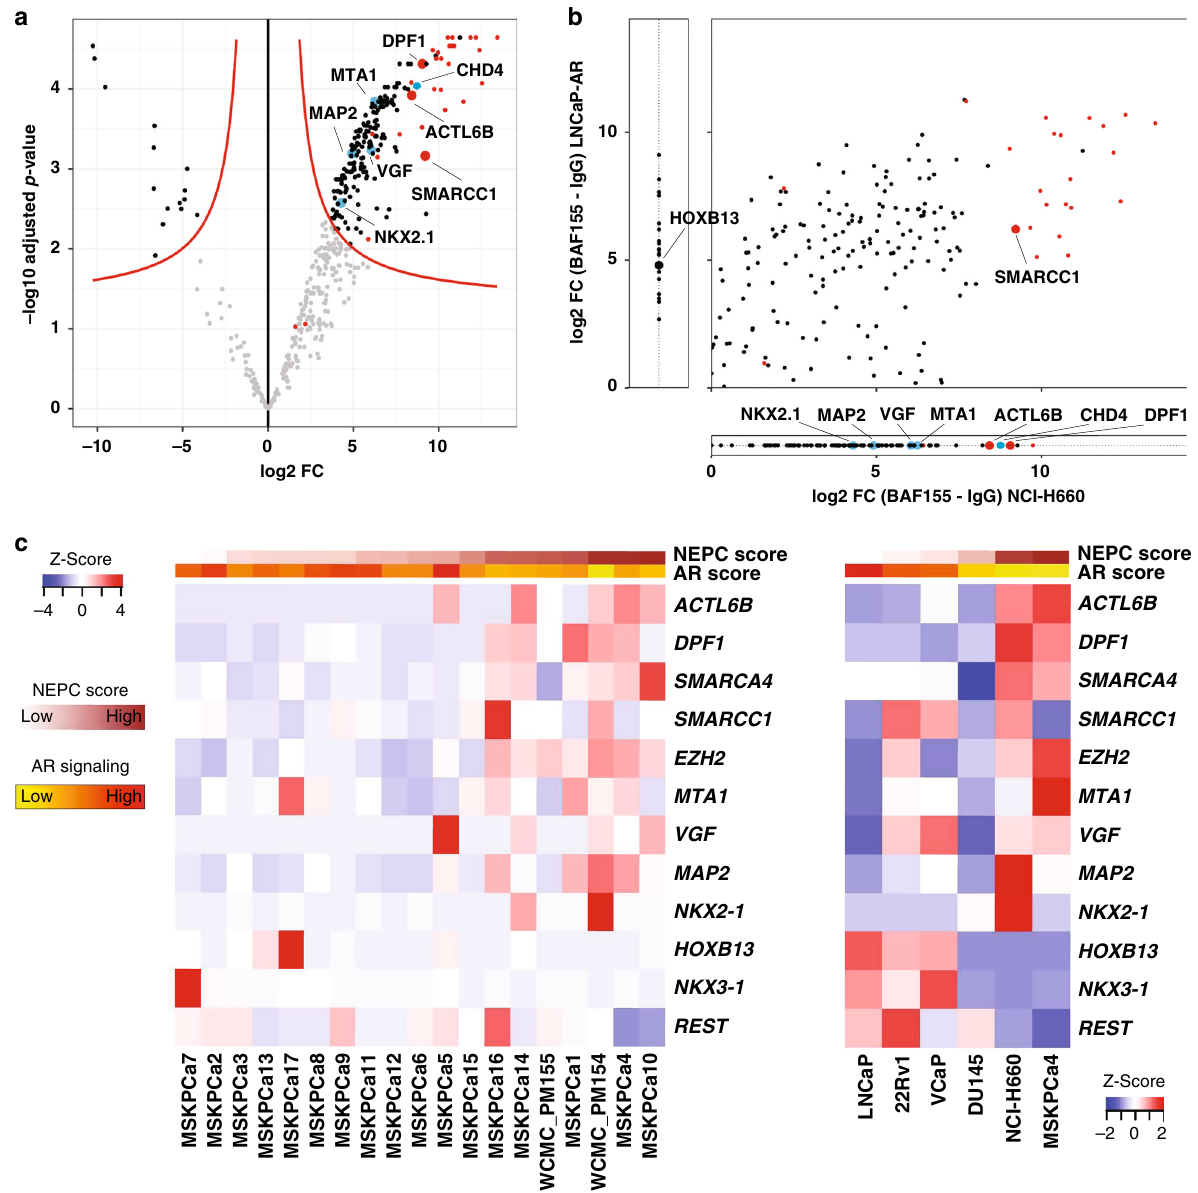
Fig. 4 SWI/SNF associates with different transcriptional regulators in CRPC-NE and in adenocarcinoma cells. a Volcano plot showing proteins most signi fi cantly represented (upper right) in the co-IP using an anti-BAF155 antibody, as compared to IgG isotype control in NCI-H660 (CRPC-NE) cells (pooled data from 3 co-IP replicates). The x -axis represents log2 fold change (FC) values, the y -axis represents − log10 of adjusted p -values. Each dot represents a protein; red dots represent SWI/SNF members, blue dots indicate notable fi ndings. b A qualitative representation comparing proteins associated with SWI/SNF in NCI-H660 (CRPC-NE) and in LNCaP-AR (adenocarcinoma) cells (averaged data from two co-IP experiments). Plotted are log2 fold change values between BAF155 IP and IgG IP in NCI-H660 cells ( x -axis) and in LNCaP-AR cells ( y -axis), for proteins present in both cell lines with suf fi cient evidence in each cell line (i.e., if present in two replicates of at least one condition). Proteins plotted outside of the main fi eld represent proteins that were detected exclusively in one of the cell lines. c Heatmap showing RNA-seq expression (FPKM) of prostate cancer 3D organoids (left) and 2D cell lines (right), ordered by increasing NEPC